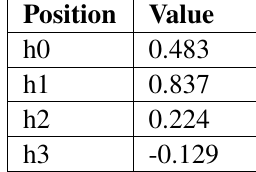
Table 1 Daubechies wavelet transform